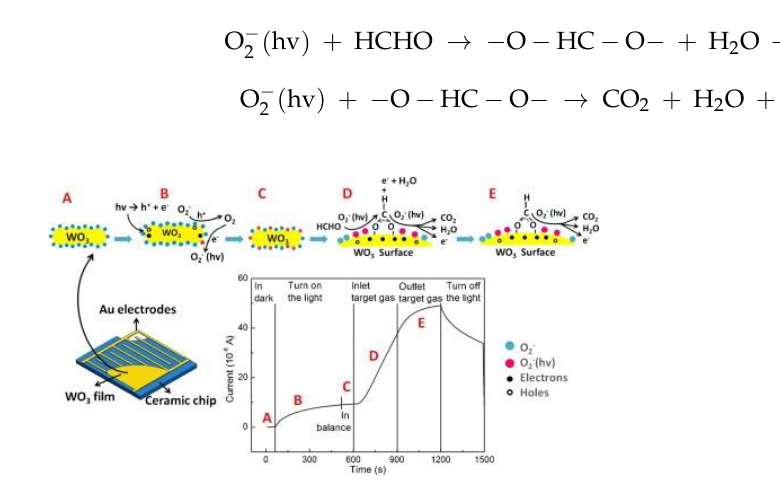
Figure 19. Diagram illustrating the visible-light-activated gas sensing mechanism at room temper- ature [105].